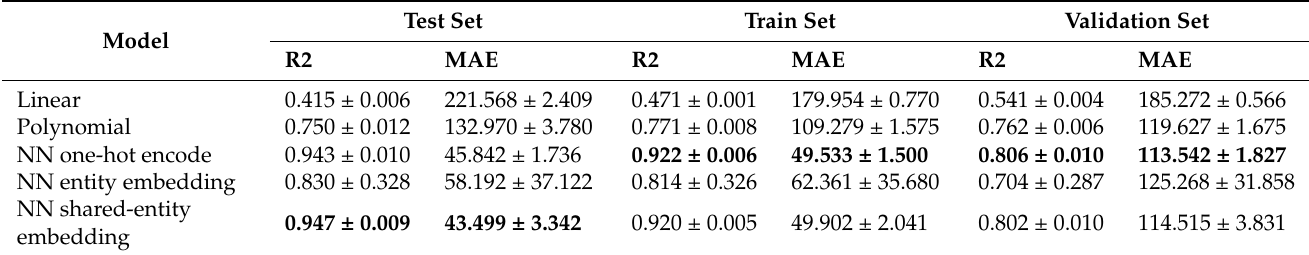
Table 6. Model performance without using the orientation feature. The best performing models are in bold. Model